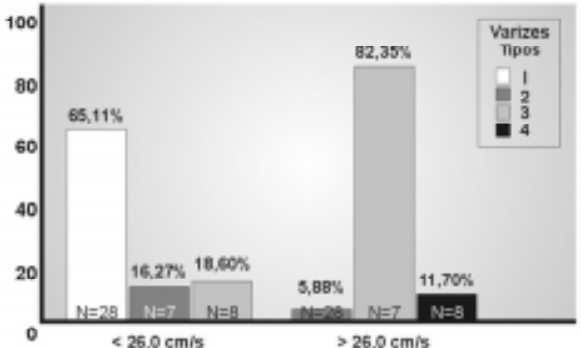
Fig. 1 - Correlation between iliac valvular regurgitation and severity of the varicose Table 2. Correlation among the varicose veins and saphenous ostial valvular regurgitation.